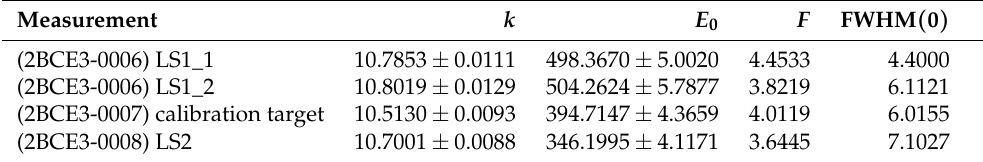
Table 5. Parameter values for the linear relationship between the peak energy and the channel.